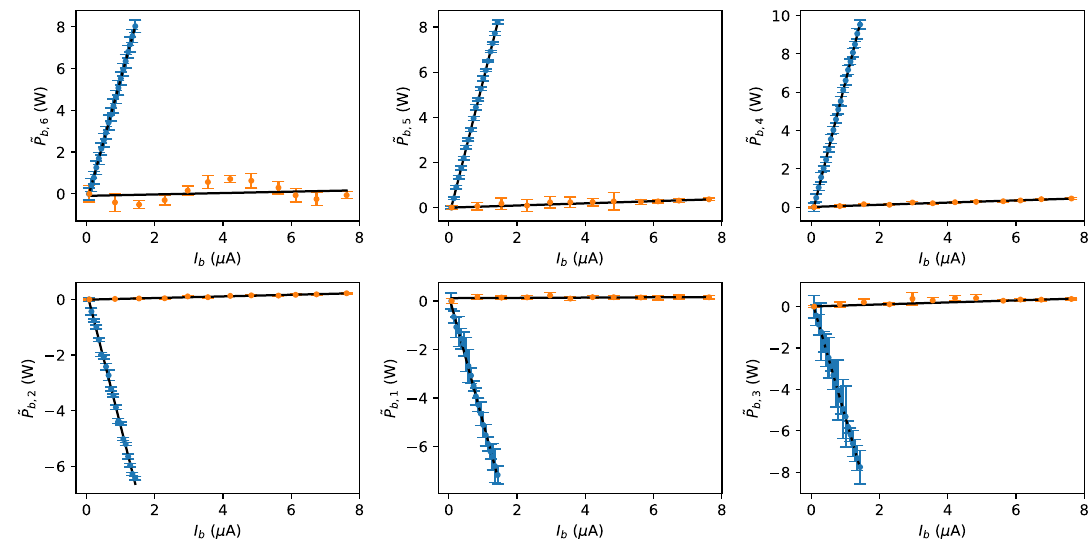
FIG. 5. Beam loading as a function of current in all six cavities of the main linac. The blue data represent loading in the 3 up, 3 down configuration, clearly showing cavities the first three cavities transferring power to the beam while last three recover energy from the beam. The orange data show the beam loading during ER operation. Linear fits to the data are shown in black and are used to extract the slope of the beam loading per unit current.